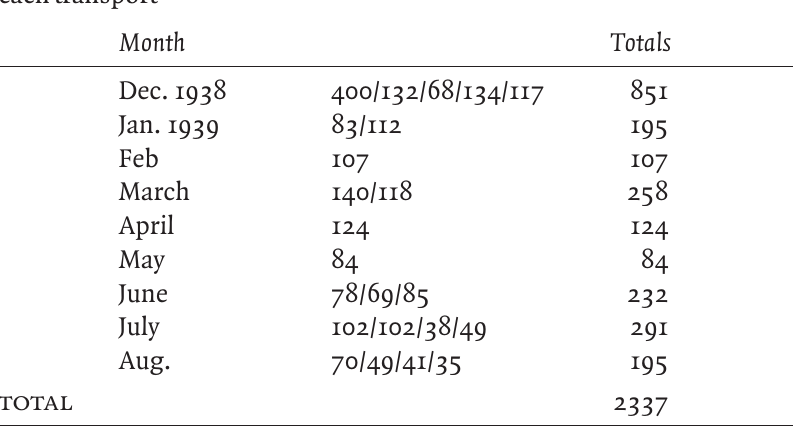
Numbers of Vienna Kindertransportees to “England” on each transport